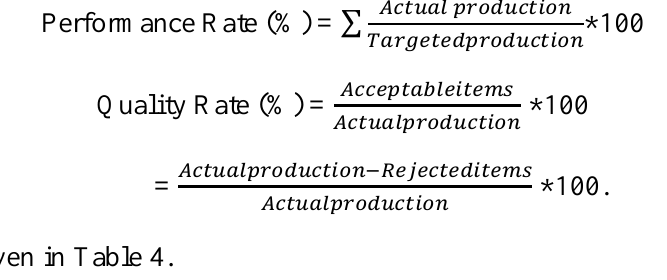
Table 4. Initial OEE